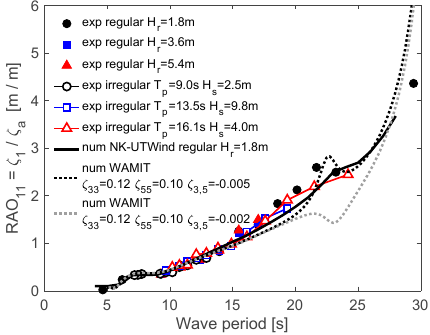
Figure 10. RAO surge motion result comparisons between the experiment and numerical calculations.